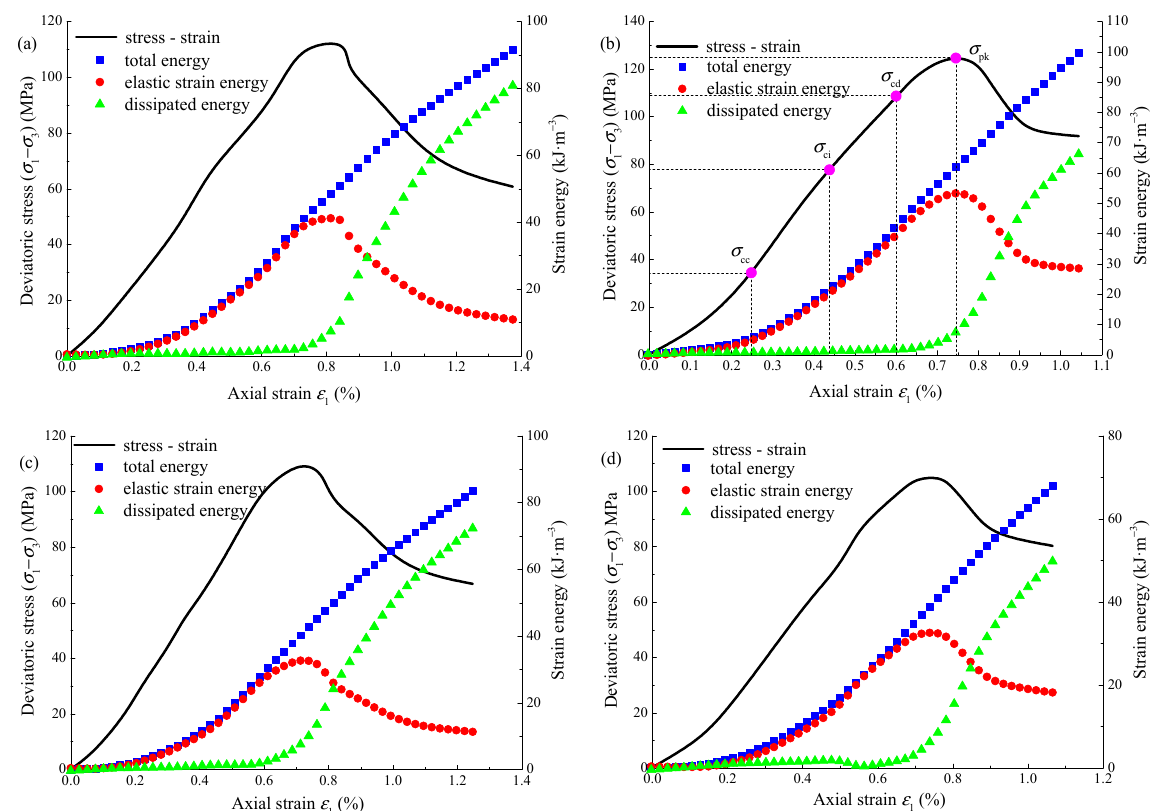
energy is still the main stage. When the axial stress reaches the peak strength σ pk , the elastic strain energy releases rapidly, the dissipated energy increases rapidly.